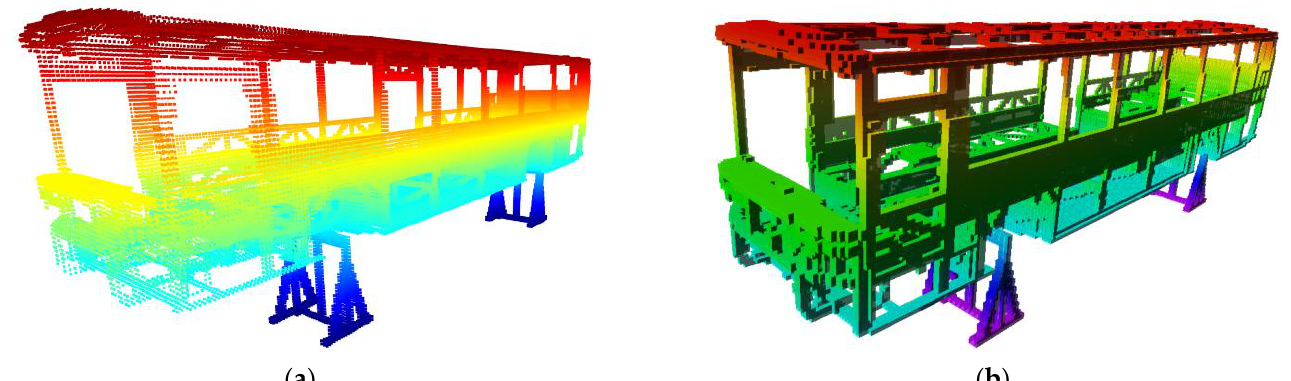
Figure 12. Mapping by CAD models for bus body: ( a ) point clouds, ( b ) 3D octree-based occupancy map.